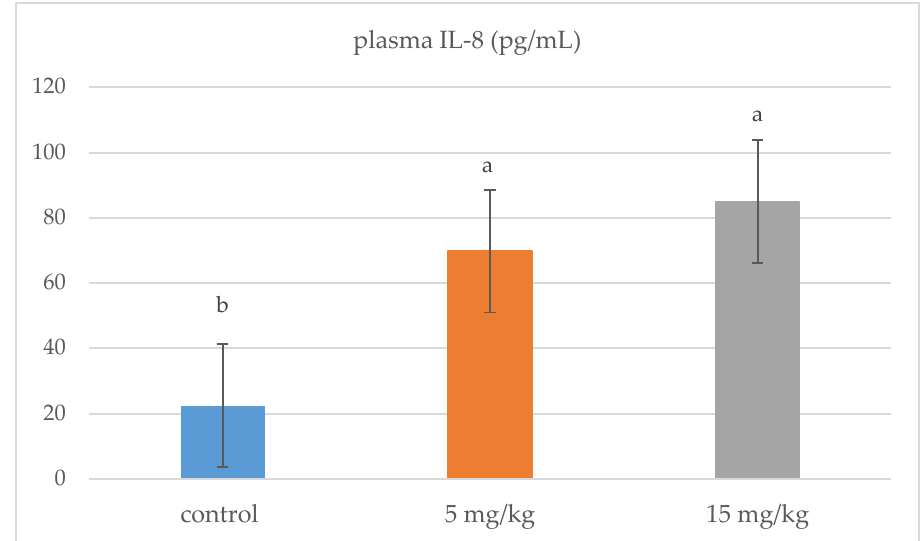
Figure 1. Effects of DON-contaminated feed (5 and 15 mg/kg) on plasma IL-8 levels in broiler chickens. Bars show the means and the standard error of mean (SEM) ( n = 5); a,b, : values with different superscripts for each cytokine differ ( p ≤ 0.05).